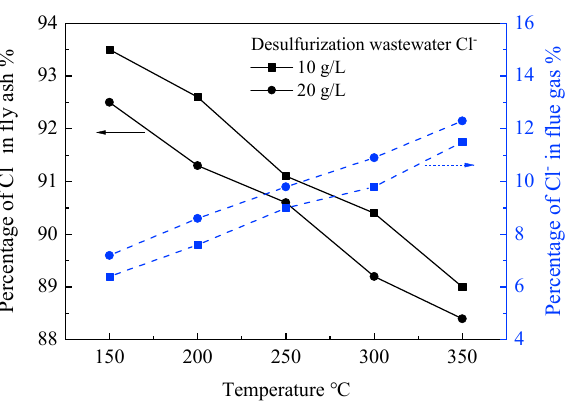
Figure 3. Evaporated Cl − distribution of desulfurization wastewater with different Cl − concentrations.